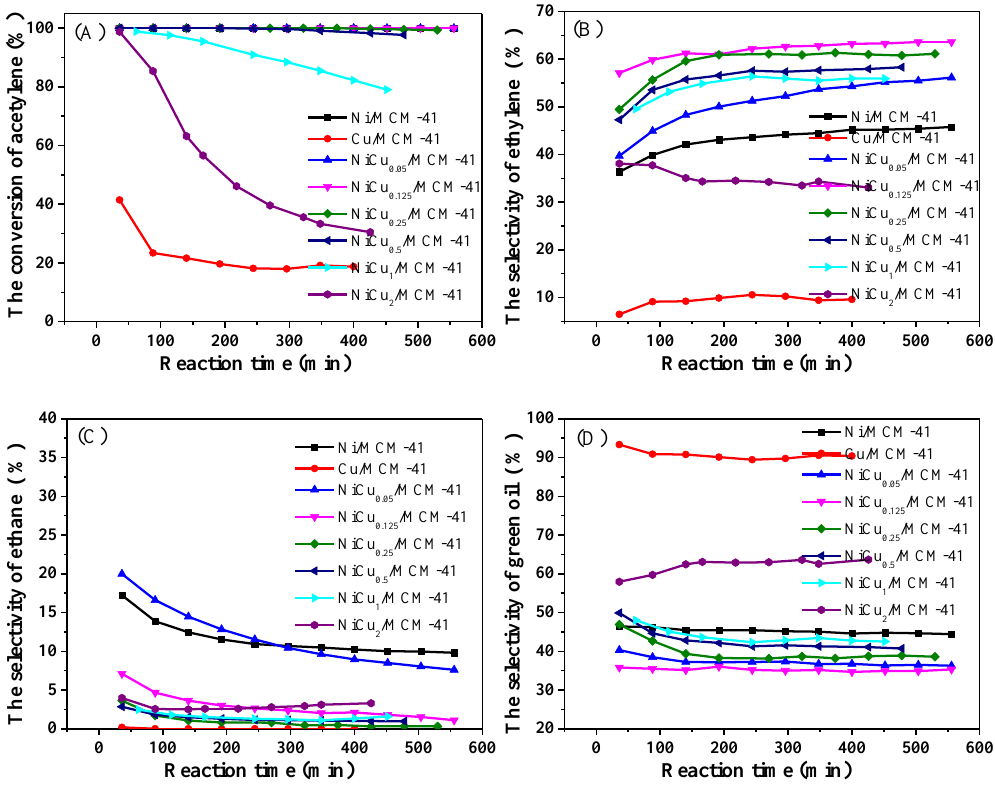
Figure 2. Catalytic performance of different catalysts at 8000 mL·g −1 ·h −1 , 250 °C, and V(H 2 )/V(C 2 H 2 ) = 3; ( A ) acetylene conversion, ( B ) ethylene selectivity, ( C ) ethane selectivity, ( D ) green oil selectivity.